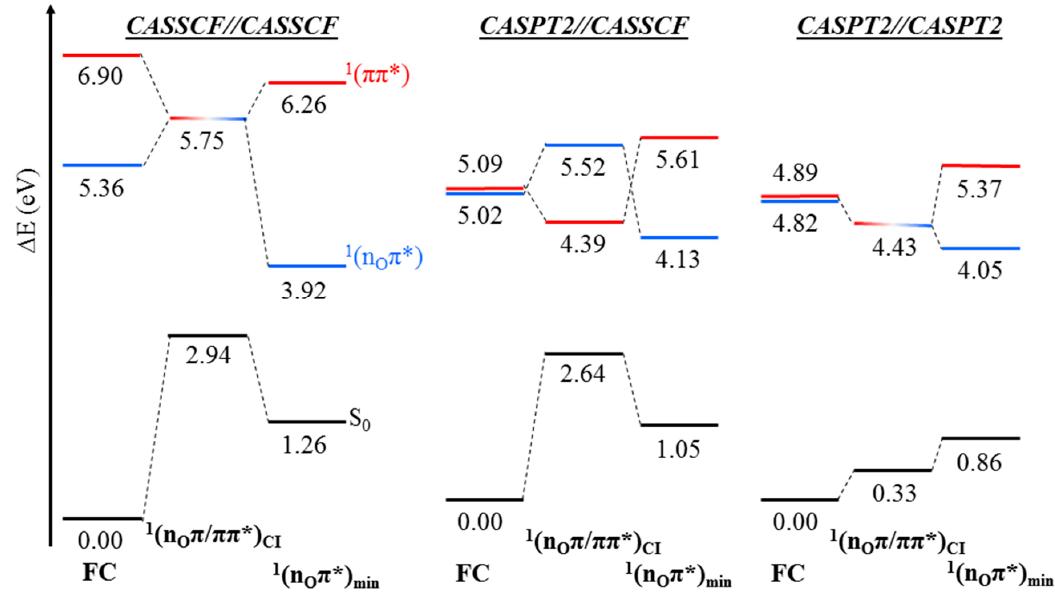
Figure 5. CASSCF//CASSCF, CASPT2//CASSCF, and CASPT2//CASPT2 energy diagrams of the key structures predicted to partake in the deactivation along the 1 (n O π *) state. Results were obtained with the (14,10) active space and the 6-31G* basis set.